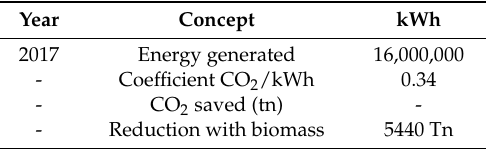
Table 9. Direct reduction of CO 2